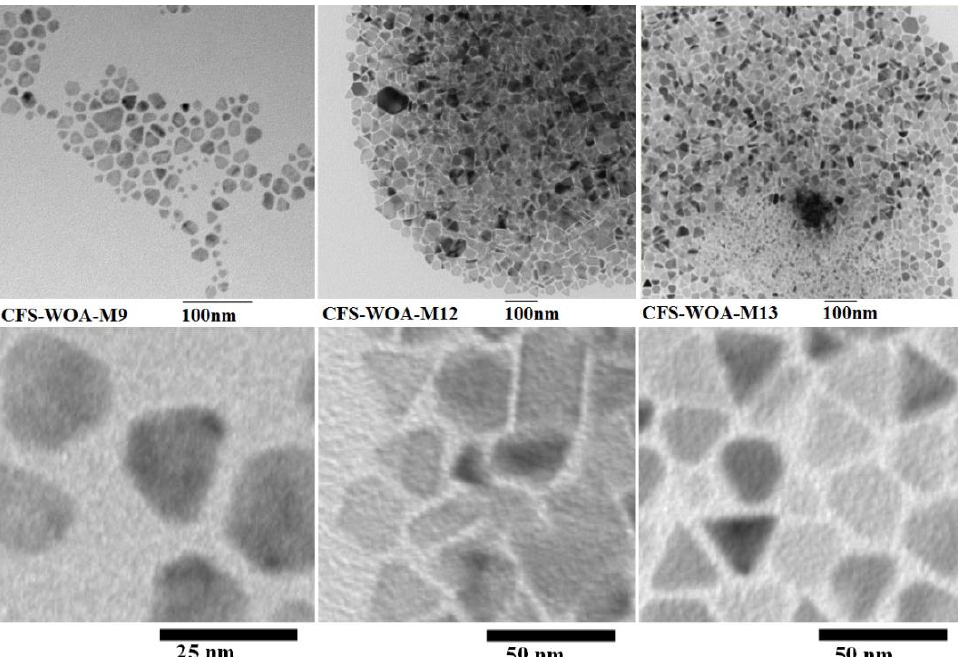
Fig. 4. Effect of different solvents on the morphology of synthesized